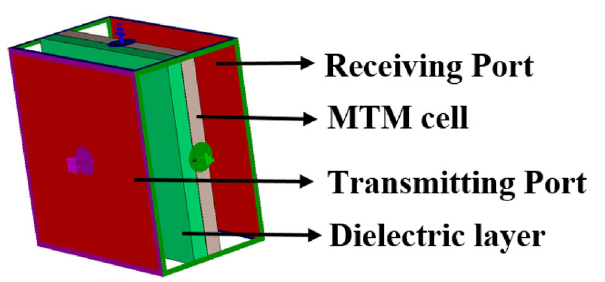
Figure 7. Simulation arrangement for dielectric layer with MTM (CST microwave studio suite